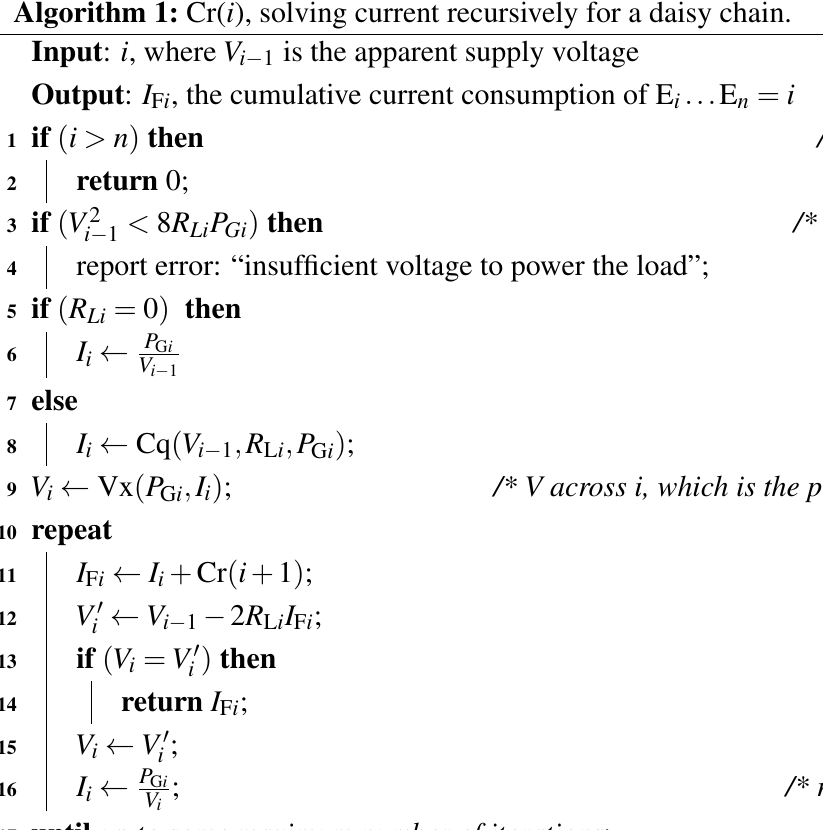
Algorithm 1: Cr( i ), solving current recursively for a daisy